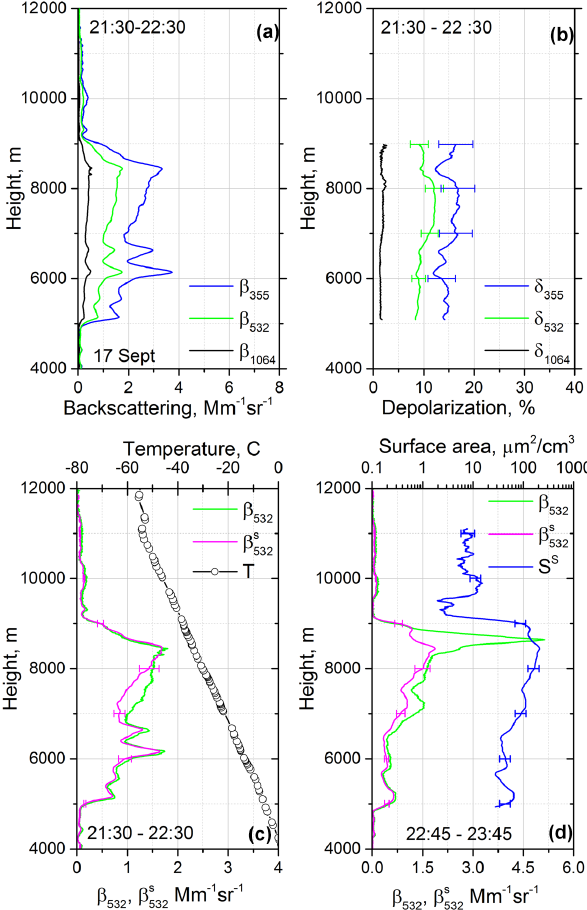
Figure 10. Formation of ice particles at 8.5–8.6km height inside a smoke layer on 17 September 2020. Vertical profiles of (a) the aerosol backscattering coefficients β 355 , β 532 and β 1064 ; (b) the particle depolarization ratios δ 355 , δ 532 and δ 1064 ; and (c, d) β 532 , together with backscattering coefficient of smoke β s , calculated 532 from fluorescence backscattering β F assuming G F = 3.5 × 10 − 4 . (d) 22:45–23:45UTC, which are prior to and during ice formation at 8.5km height. Panel (d) shows also the surface area concentra- tion of the smoke particle S S calculated from β F by applying the respective conversion factor from Eq. (3). The temperature profile measured by the radiosonde at Herstmonceux is shown with open symbols in panel (c)